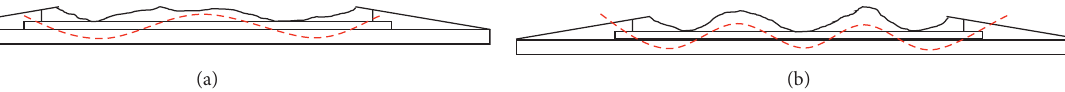
Figure 11: Comparison of irregular abrasion profiles and vertical modal shapes.